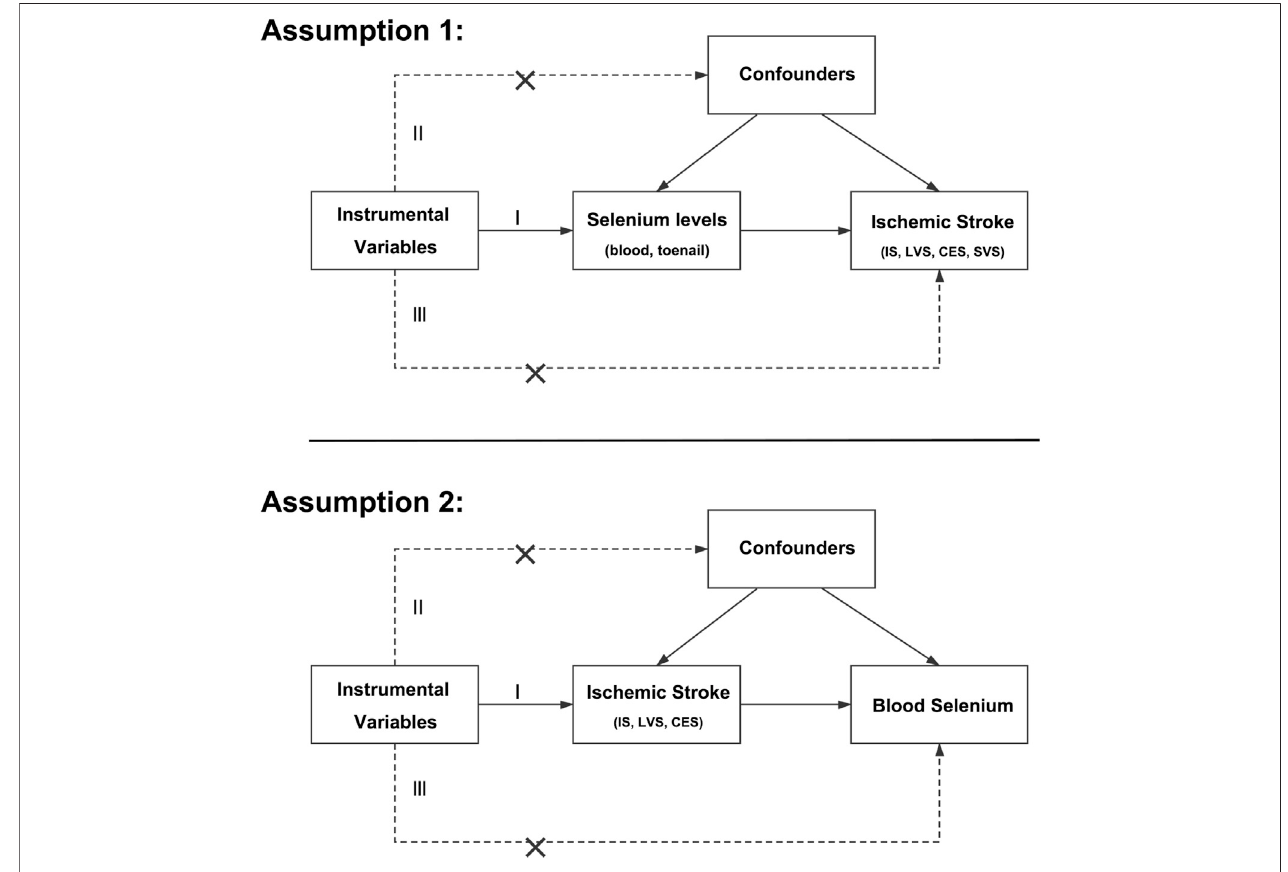
FIGURE1| Mainassumptions oftheMendelianrandomizationstudyofseleniumlevelsandischemicstroke. IS,ischemicstroke; LVS,large-vesselatherosclerosis stroke; CES, cardio-embolic stroke; SVS, small-vessel occlusion stroke.